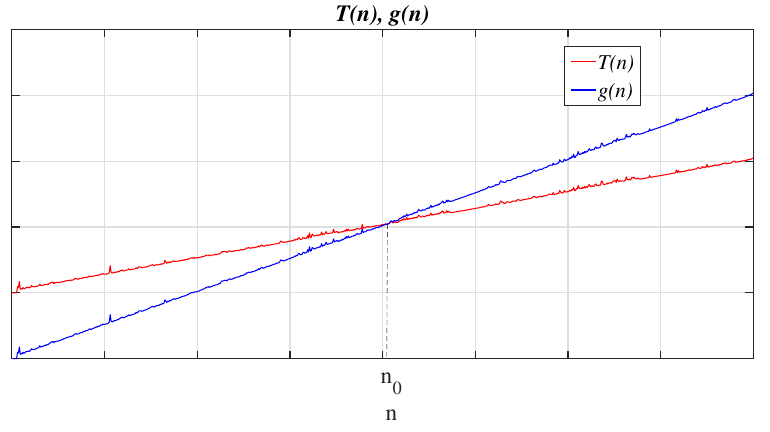
Figure 14. Definition of upper or lower bound using function g ( n ) for temporary complexity